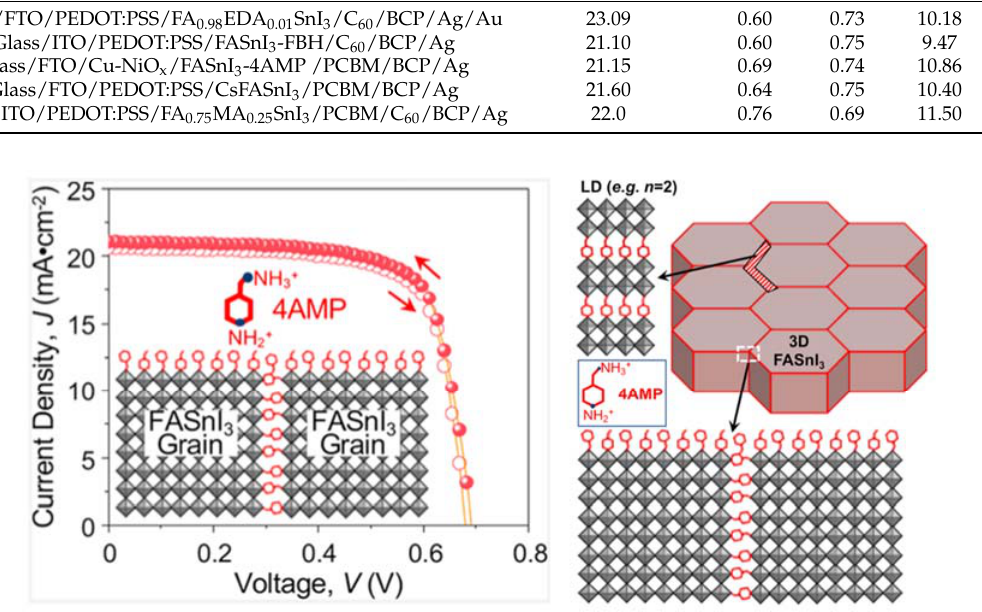
Table 7. Record table containing the reported Sn-PSCs and the corresponding photovoltaic parameters mentioned in Section 2.6. Report Year [Ref.]